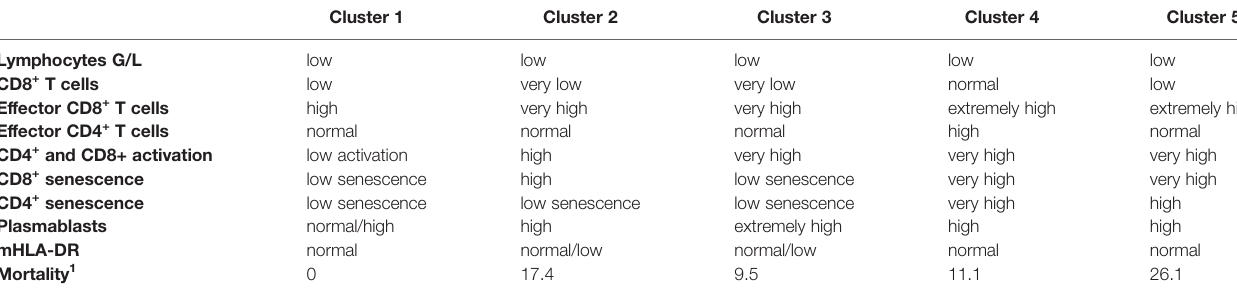
TABLE 6 | Major characteristics of the fi ve clusters of patients.